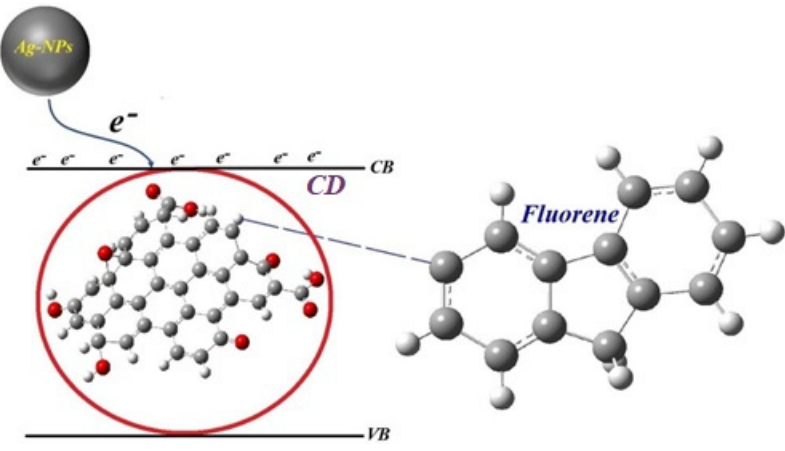
Figure 11. The diagram for the integration of Ag–NPs / CD with fluoride.